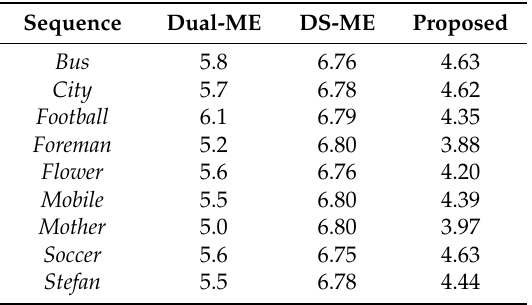
Table 3. The average processing time (s/frame) comparison of different ME methods for the test sequences. Sequence